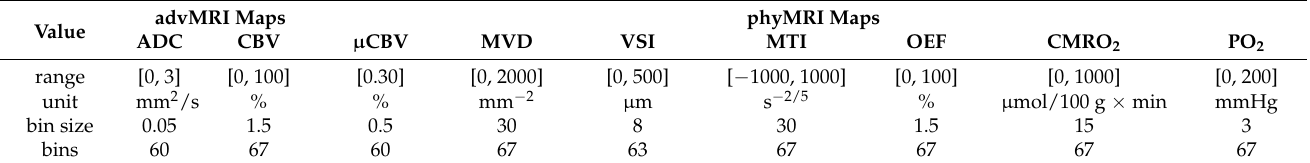
Figure 1. General diagram of the proposed radiomics and radiophysiomics approach, showing the major steps: MRI data acquisition; calculation of imaging biomarkers; extraction of radiomic features, including tumor and edema segmentation, data filtering, and feature extraction; reduction in and selection of the most relevant features; development and validation of ML-based classification models; and testing the performance of the best-performing classifiers. Table 1. Value ranges, bin sizes, and bin numbers for discretization of biomarker